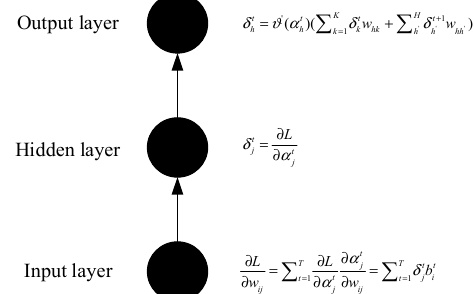
Figure 3. Forward propagation of Recurrent Neural Networks.